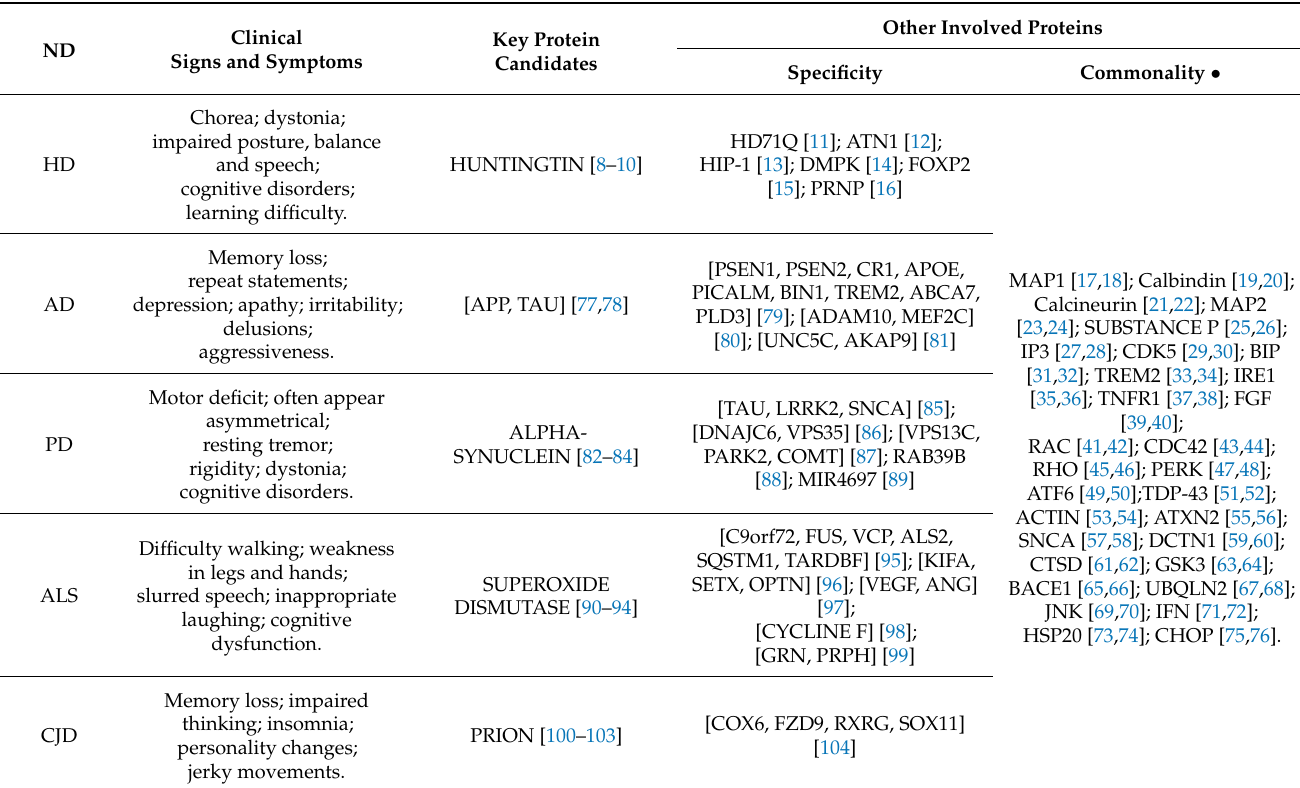
Table 1. Overview of clinical symptoms and proteinopathies in major ND. The clinical presentation of ND patients is heterogeneous, although it often has overlapping features such as cognitive impair- ment. The main specific (limited to a disease) and common (found in several diseases) well-known representative proteins involved in Alzheimer’s, Parkinson’s, Huntington’s diseases, amyotrophic lateral sclerosis, and Creutzfeld-Jakob neurodegenerative disorders are presented. • cjd excluded. Other Involved Proteins Clinical Key Protein ND Signs and Symptoms Candidates